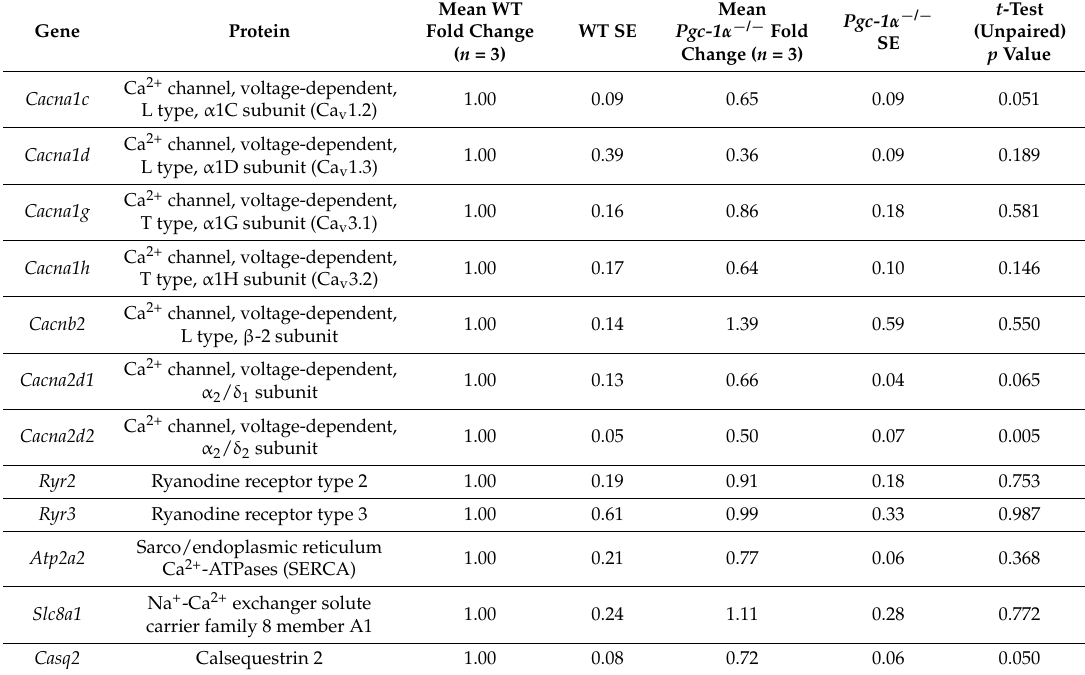
Table 4. The mean gene fold changes underlying Ca 2+ homeostasis in Pgc-1 α − / − compared to WT atria.